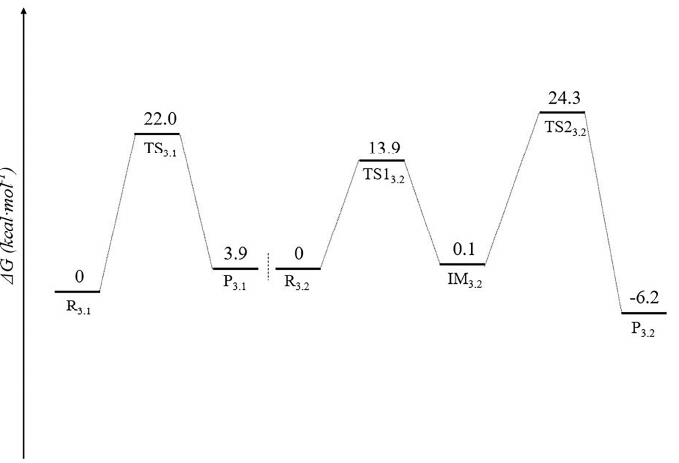
Figure 7. Under the calculated level of CAM-B3LYP/6 − 31+G**, the energy diagram of Stage 3.